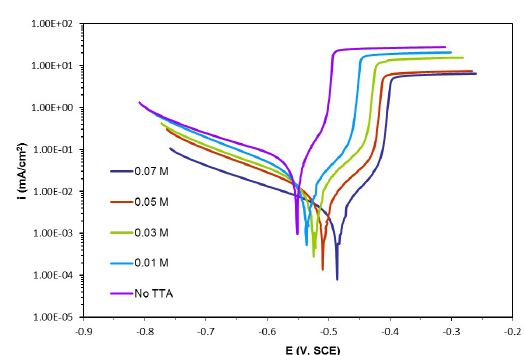
Figure 3. Potentiostatic polarization curves of mild steel in 0.5 M HCl solution with various concentrations of TTA (0 to 0.07 M) at room temperature (293